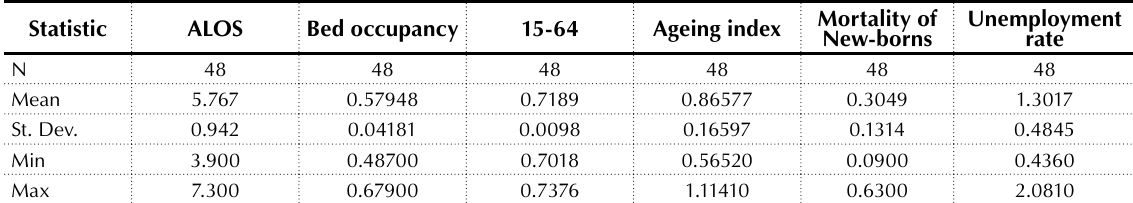
Source: Own processing according to data provided by NHIC and Eurostat.